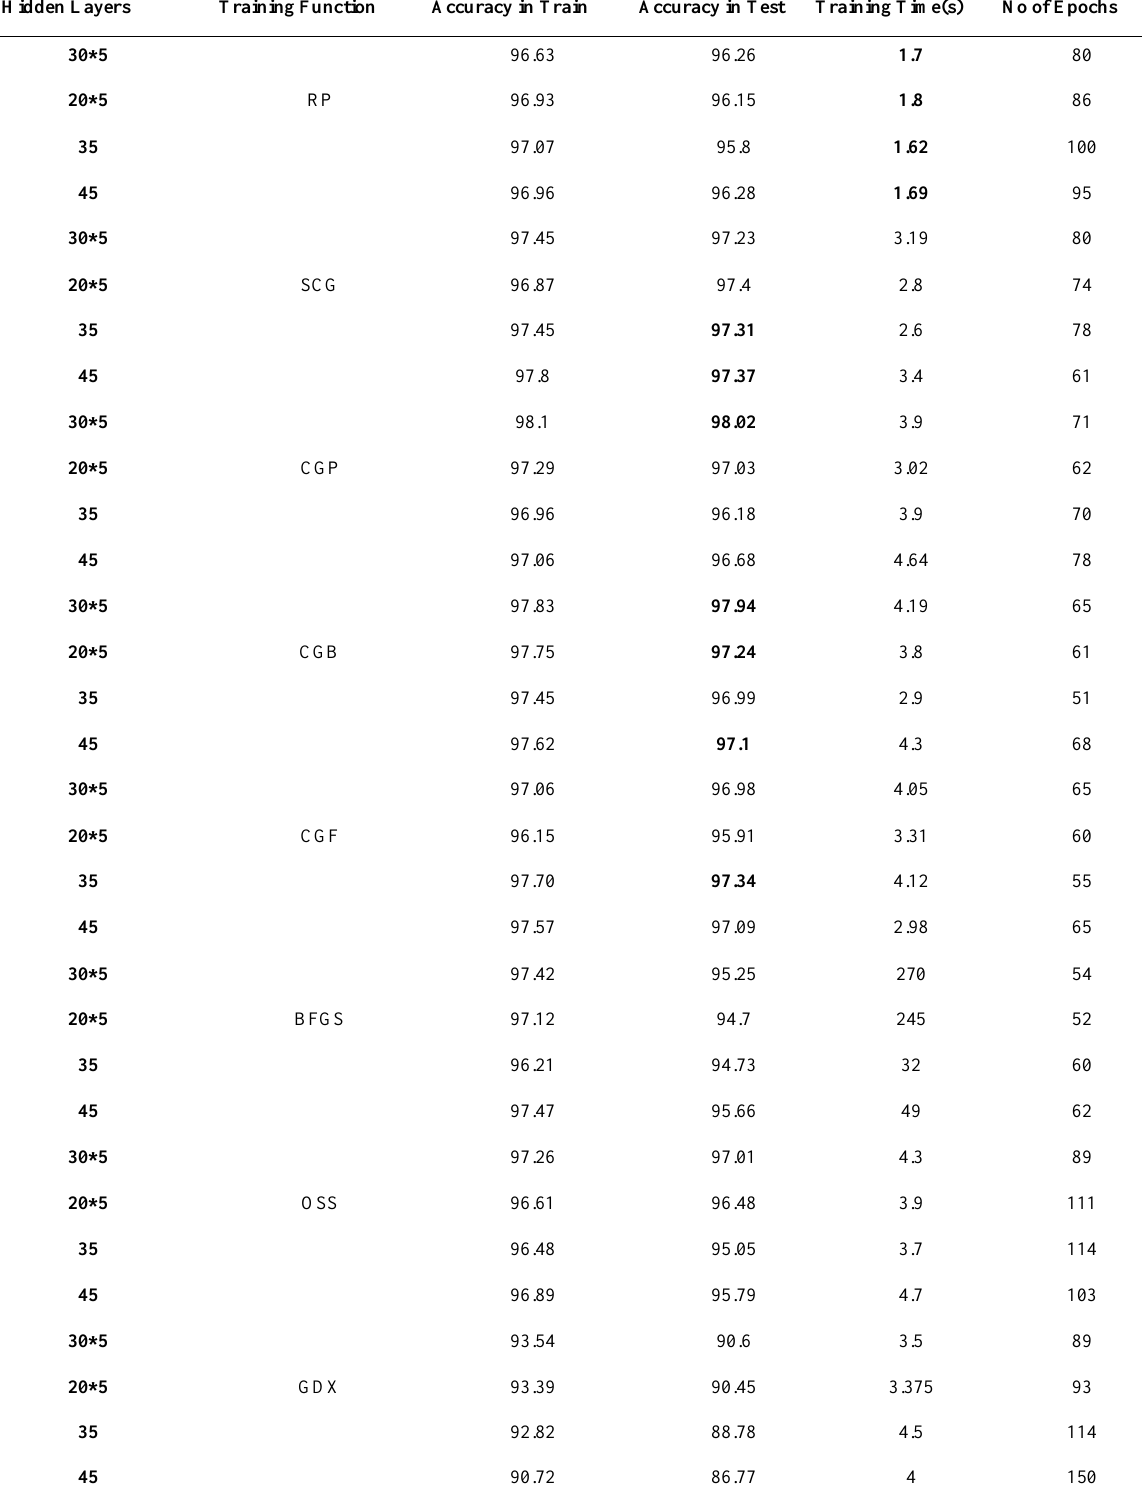
Table 4. Comparison among the speed of convergence of different training algorithms for detection of PVC arrhythmia. Hidden Layers Training Function Accuracy in Train Accuracy in